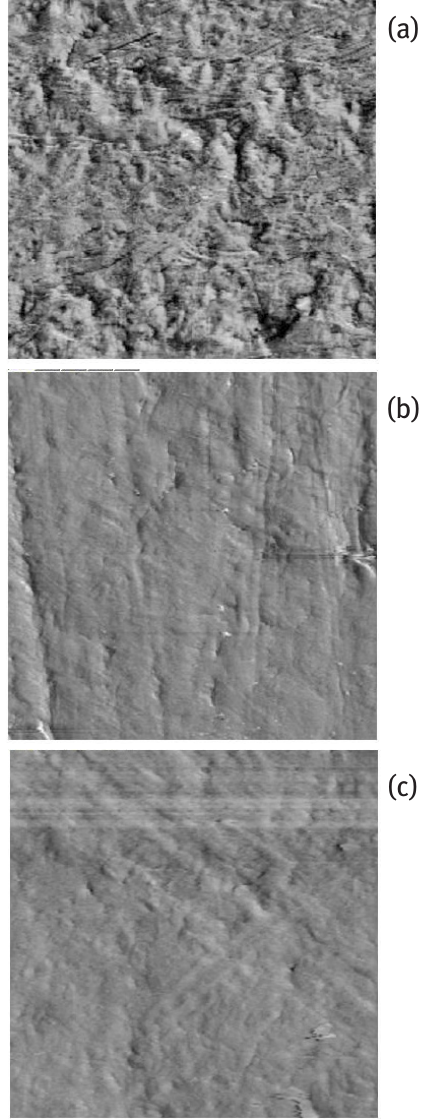
Figure 5 : Friction images of the untreated (a), plasma-treated (b) surfaces, and plasma-treated surface coated with PVP/TAN/PVP layer (c), visualized by atomic force microscopy in aqueous